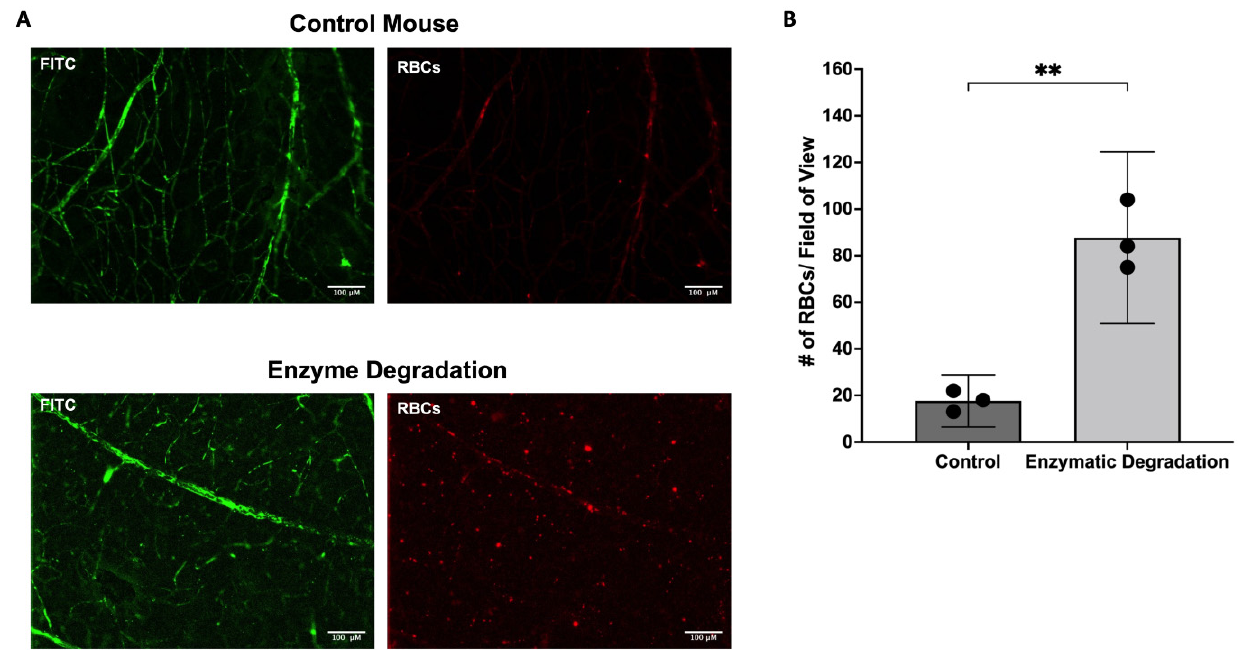
Figure 5. Effect of the Endothelial Glycocalyx on Retinal Microhematocrit. ( A , B ) Representative images and quantification of the number of RBC per field of view in control mice and mice infused with hyaluronidase and heparinase (n = 3); means with 95% confidence intervals. ** p < 0.01. Scale bar = 100 μ m.